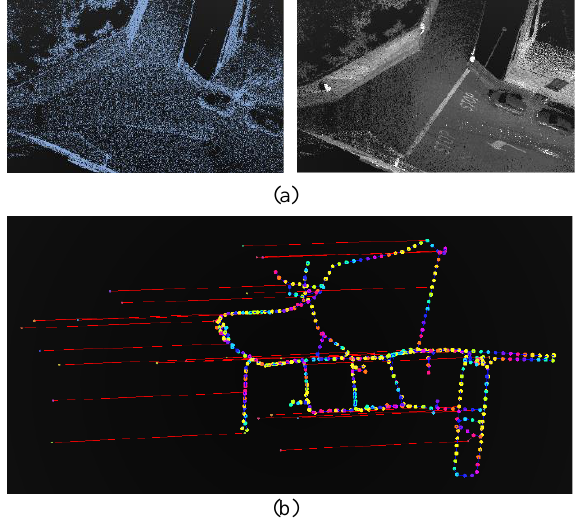
Figure 6. (a) Comparison between the standard version of Local Maps normally displayed to the user and the high-resolution version loaded for precise detection of GCPs; (b) Matches among GCPs in the reference position and identified on Local